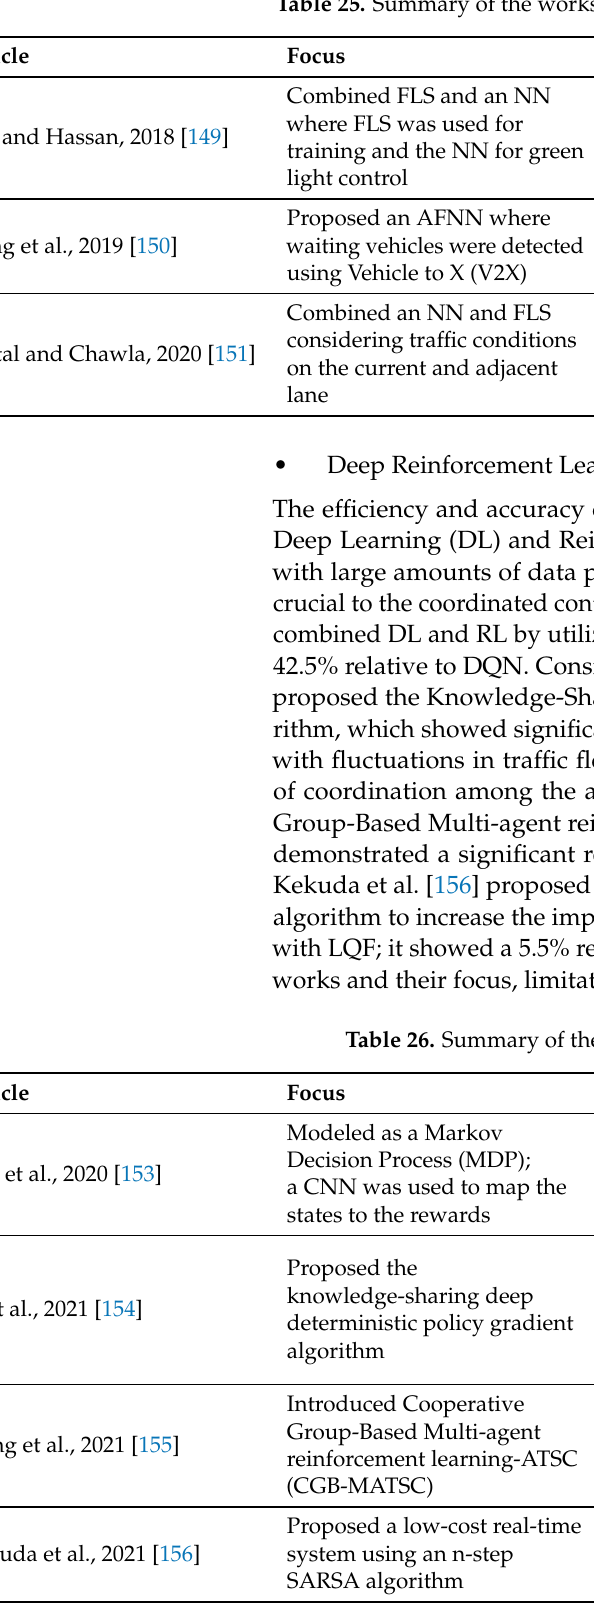
Table 25. Summary of the works found combining NNs and FLS.